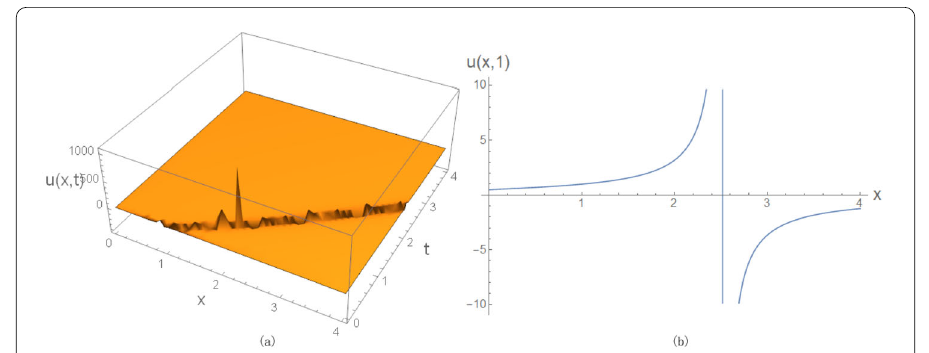
Figure 1 ( a ) Three-dimensional figure of (24),when κ = 1, c = 1, and ξ 0 = 1; ( b ) the corresponding two-dimensional figure when t = 1